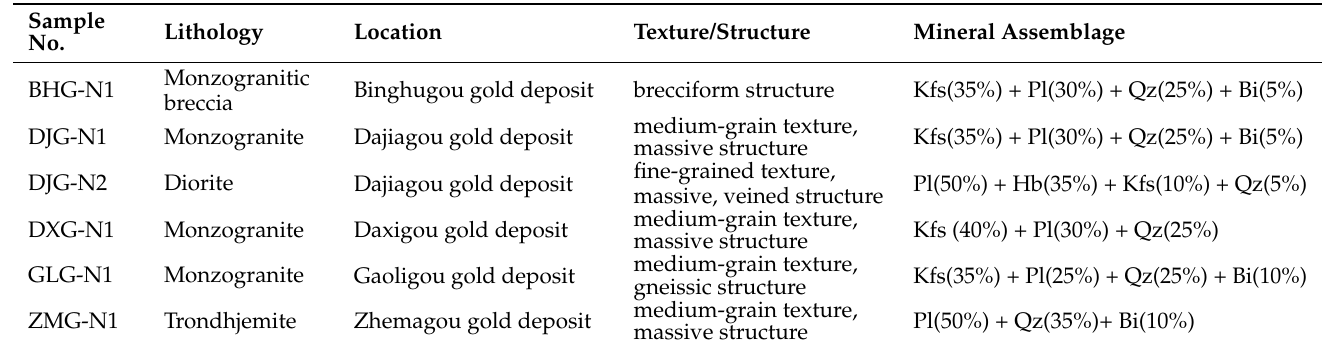
Table 1. Simplified locations and petrological characteristics for the samples from the Liuhe orefield, NE China.